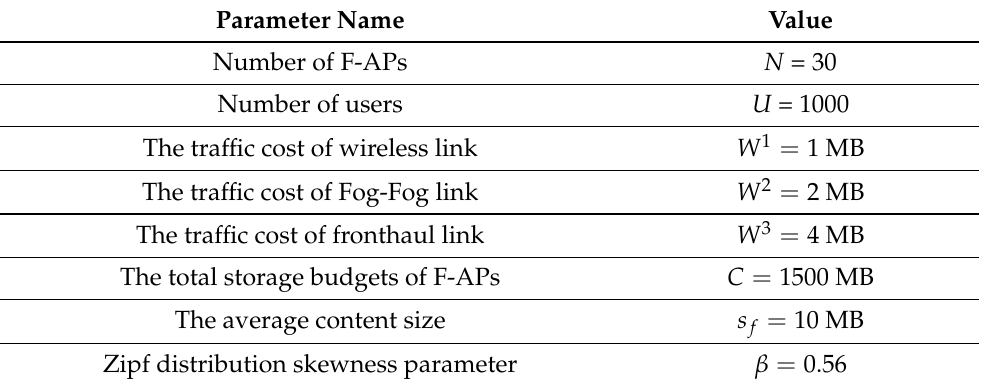
Table 3. Simulation